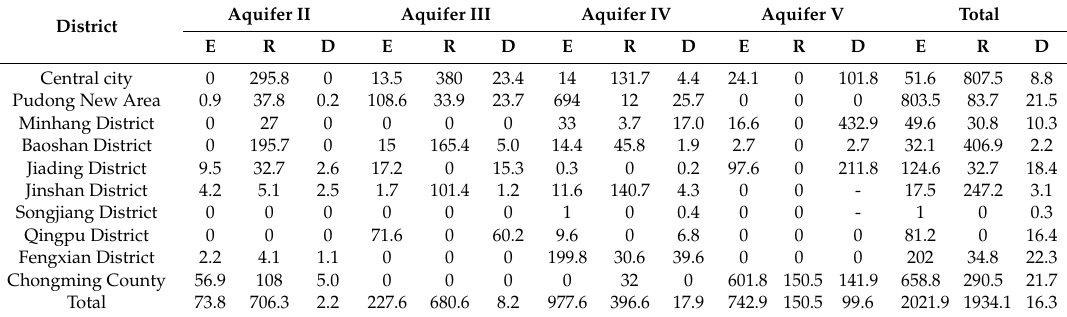
Figure 6: 1921–1965 was a period of serious land subsidence in Shanghai, with an average land subsidence in urban area of 1760 mm, average annual subsidence of 39 mm, and maximum cumulative subsidence of 2630 mm.